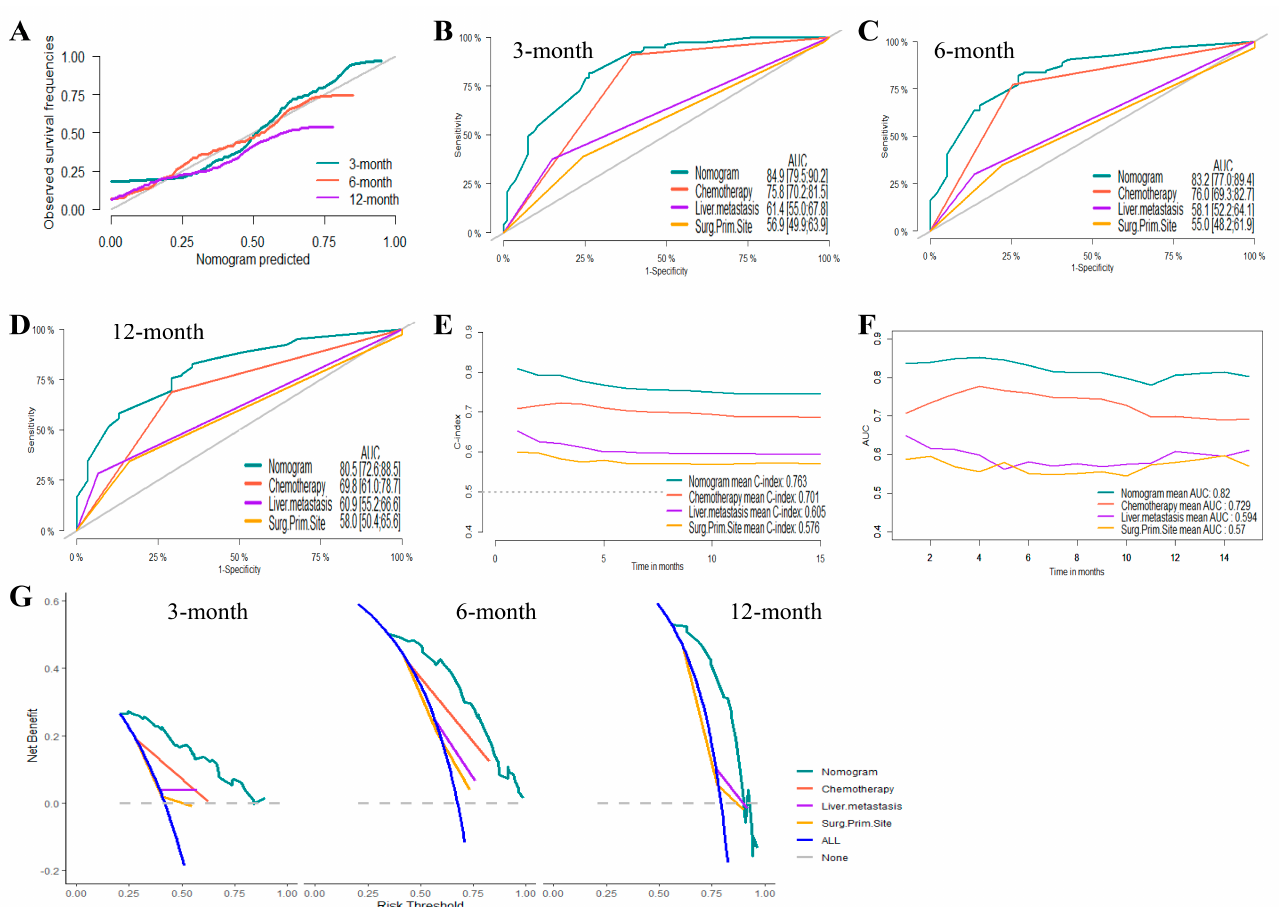
Figure 4. Evaluation of the nomogram on an external testing dataset for overall survival (OS). ( A ) 3-, 6-, and 12-month calibration plots of nomogram; ( B ) 3-month; ( C ) 6-month; and ( D ) 12-month area under the curve (AUC) for receiver operating characteristic (ROC) curves of nomogram, chemotherapy, liver metastasis, and primary site surgery; ( E ) overall concordance index (c-index) of nomogram, chemotherapy, liver metastasis, and primary site surgery; ( F ) Overall AUC of nomogram, chemotherapy, liver metastasis, and primary site surgery; ( G ) 3-, 6-, and 12-month decision curve analysis (DCA) of nomogram, chemotherapy, liver metastasis, and primary site surgery.